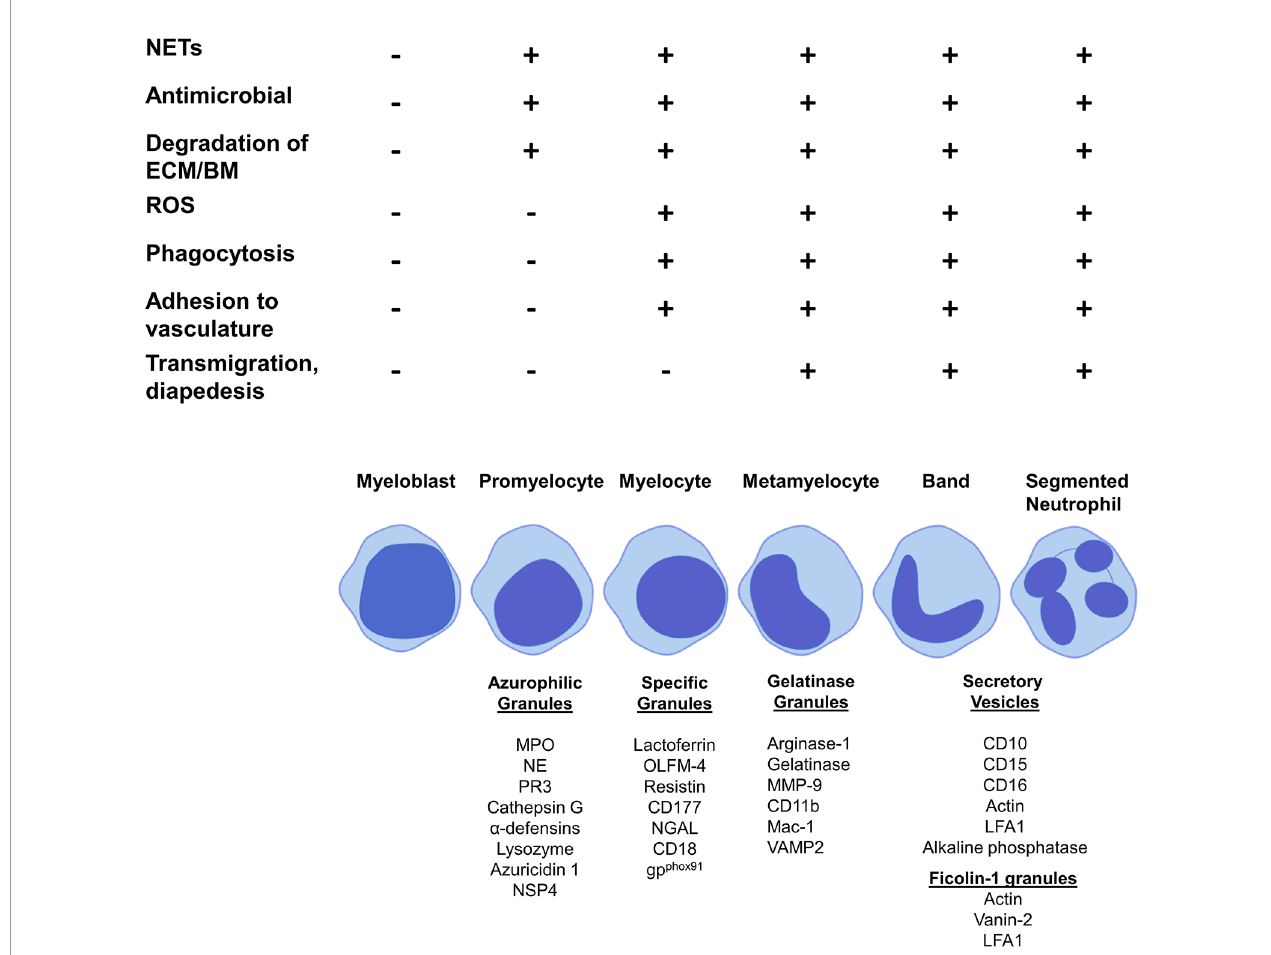
FIGURE 2 | Granule production and functionality during granulopoiesis. Figure shows granule production during the stages of granulopoiesis. Granule formation begins with azurophilic granules at the promyelocyte stage, speci fi c granules are fi rst formed by myelocytes, gelatinase granules are formed at the metamyelocyte stage and only band cells and segmented neutrophils can form fi colin-1 granules and secretory vesicles. NET formation, antimicrobial functions and degradation of the extracellular membrane and basement membrane begin at the promyelocytes stage with azurophilic granule formation. ROS production, phagocytosis and adhesion to vasculature starts at the myelocytes stage with the formation of speci fi c granules. Metamyelocytes are the fi rst stage to perform transmigration and diapedesis through a vessel wall, which correlates with gelatinase granule